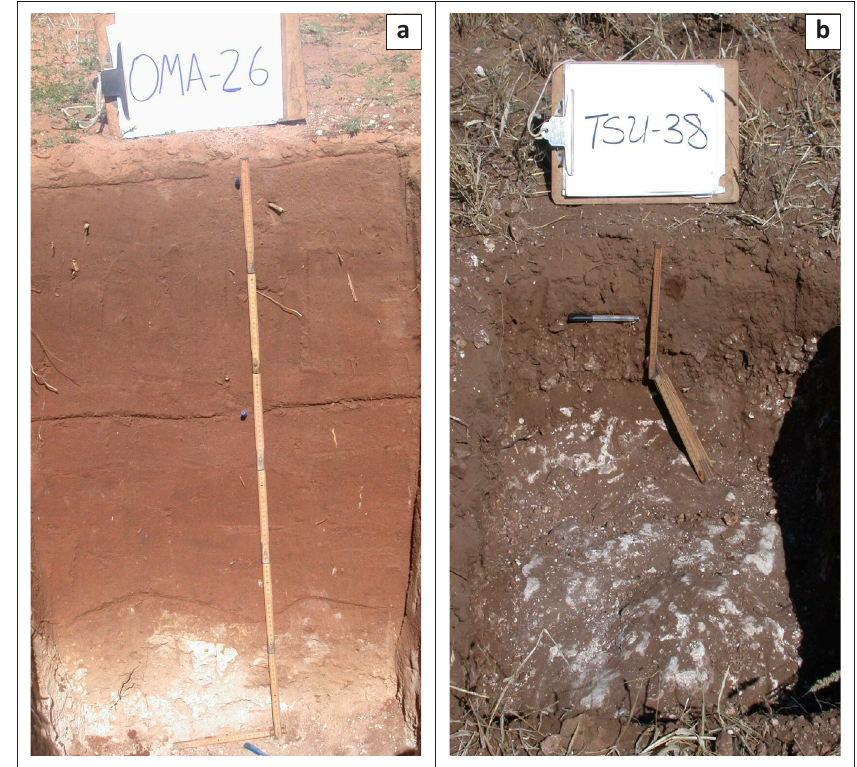
FIGURE A1.8: (a) A typical petric Calcisol, consisting of an ochric A-horizon over a moderately deep B-horizon FIGURE A1.7: Typical profile of a ferralic Arenosol, overlying soft or hard calcrete or petrocalcic horizon (white layer at the bottom). (b) An extraordinarily shallow indicating the different horizons. example of a petric Calcisol, as often found in the calcrete pans.